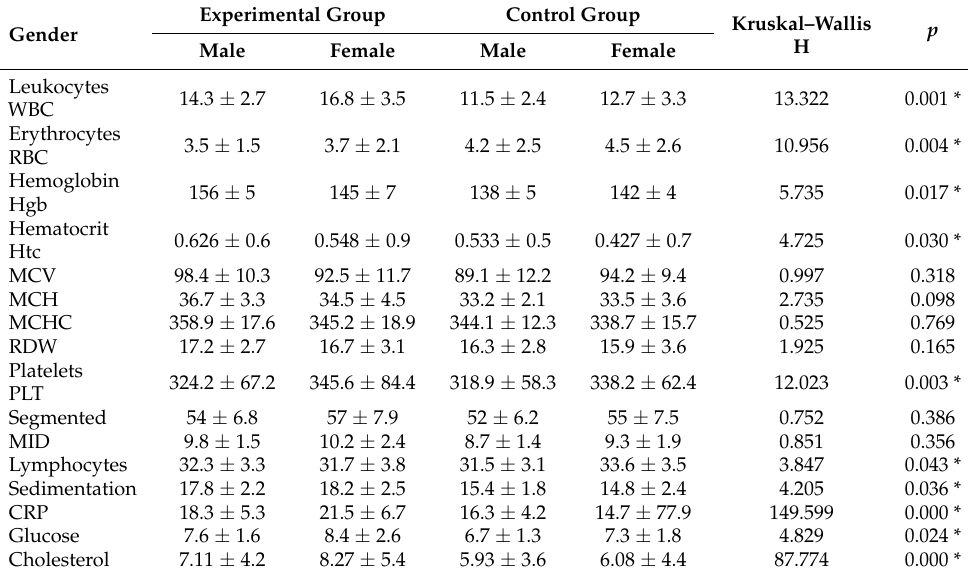
Table 6. Values of hematological and biochemical parameters measured in both groups. Experimental Group Control Group Kruskal–Wallis Gender